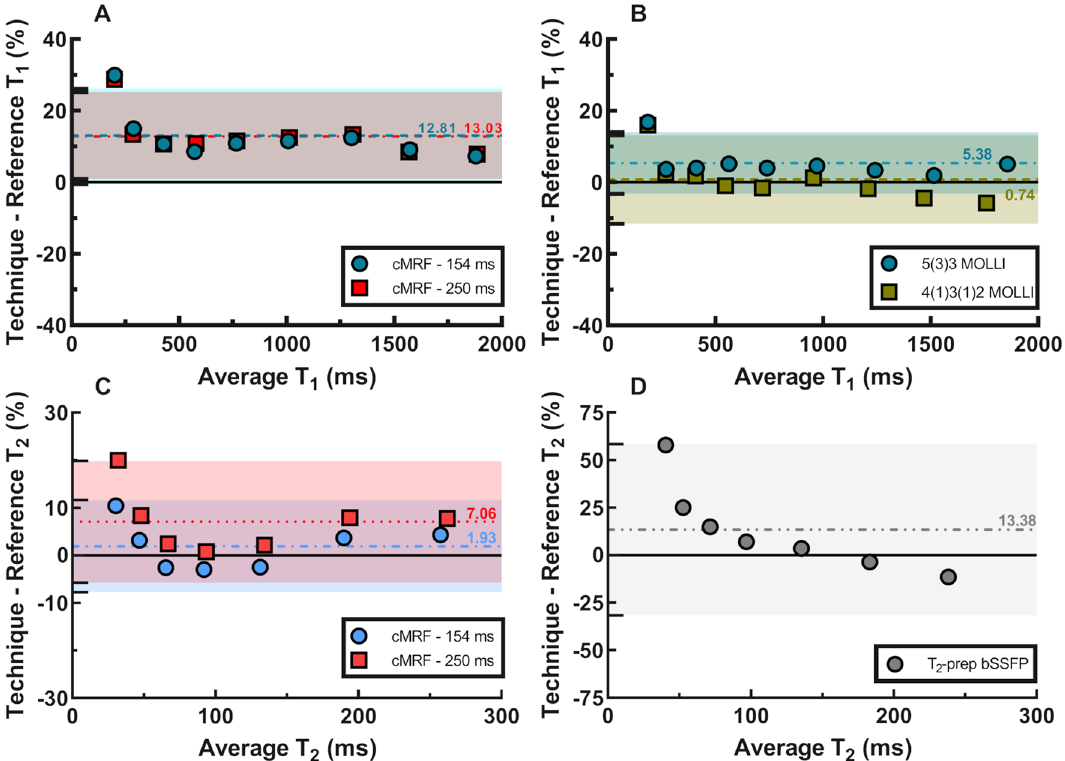
Figure 1. Accuracy of cMRF compared to reference techniques in the ISMRM-NIST phantom. ( A ) Both cMRF versions showed good agreement with one another and the bias was around 10% across a wide range of T 1 values. ( B ) The two MOLLI sequences maintained a low bias, with 5(3)3-MOLLI performing slightly better at higher T 1 values, as expected. ( C ) The cMRF T 2 measurement were consistent between the two variations, with the shorter acquisition window showing lower bias overall. ( D ) T 2 -prepared bSSFP had higher error than cMRF, likely due to the high T 1 values of the NIST phantom. The 95% confidence intervals are reported as matching semi-transparent colored bands in each plot, and the same color scheme was used to report the